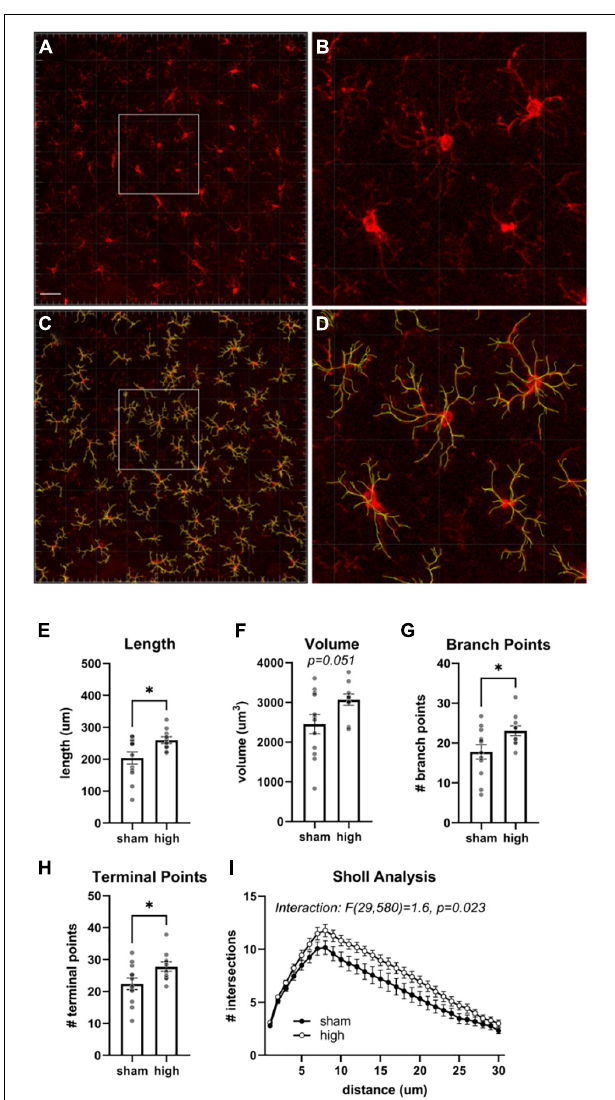
FIGURE 6 | Morphological analysis of BLA microglia/monocytes. (A) Iba1 immunoreactivity. (B) Same image as (A) overlayed with rendered filaments. Scale bars = 50 µ m. (C,D) Higher magnification views of depicted regions in (A,B) . Mean total length (E) , volume (F) , number of branch points (G) , and terminal points (H) of filaments generated from Iba immunostaining in the basolateral amygdala. (I) Sholl analysis of M/M identified by filaments analysis. Bars represent mean ± SEM. ∗ p ≤